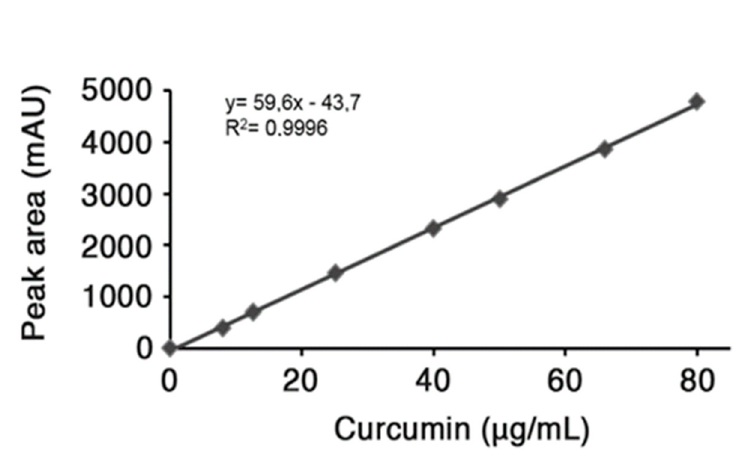
Figure 6. Calibration Curve.